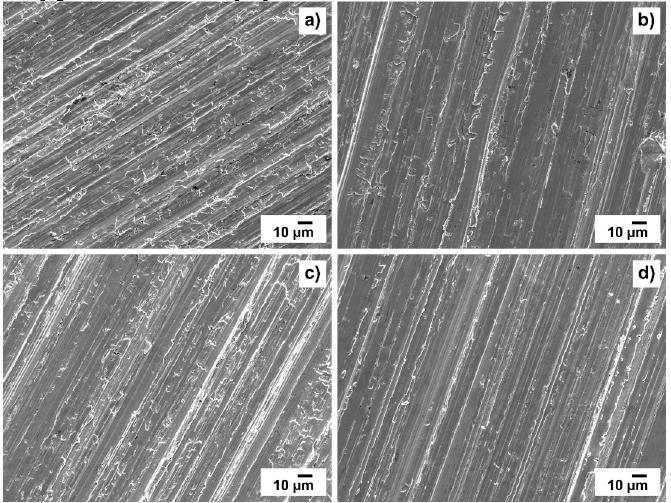
Figure 9. Worn surfaces after abrasion tests of X210Cr12 steel after: “A” treatment ( a ); “B” treatment ( b ); “C” treatment ( c ); “D” treatment ( d ).